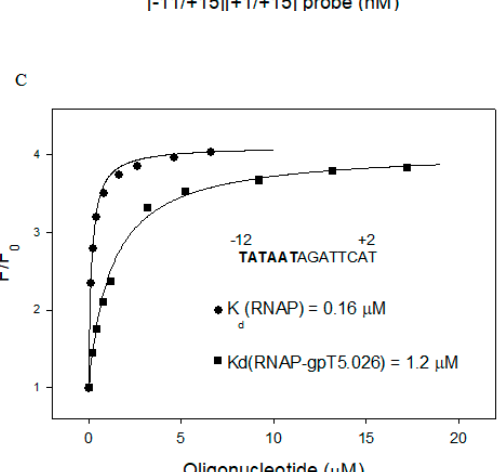
Figure 7. RNAP beacon assays reveal the e ff ect of gpT5.026 on RNAP interactions with model promoter fragments. Relative fluorescence intensity (F / F 0 ) change upon titration of [211Cys-TMR] σ 70 holoenzyme and the [211Cys-TMR] σ 70 holoenzyme preincubated with gpT5.026 (100 nM) for 15 min with the [ − 38 / − 12] upstream double-stranded probe ( A ), the [ − 11 /+ 15][ + 1 /+ 15] downstream fork junction ( B ), and the − 12 /+ 2 oligonucleotide ( C ). The solid lines correspond to a nonlinear regression fit of the data. In DNA probe names, numbers indicate probe boundaries with respect to the transcription start position, located at + 1. Numbers in left and right parentheses in the fork junction probe name correspond to boundaries of the upper and bottom strands of the fork junction